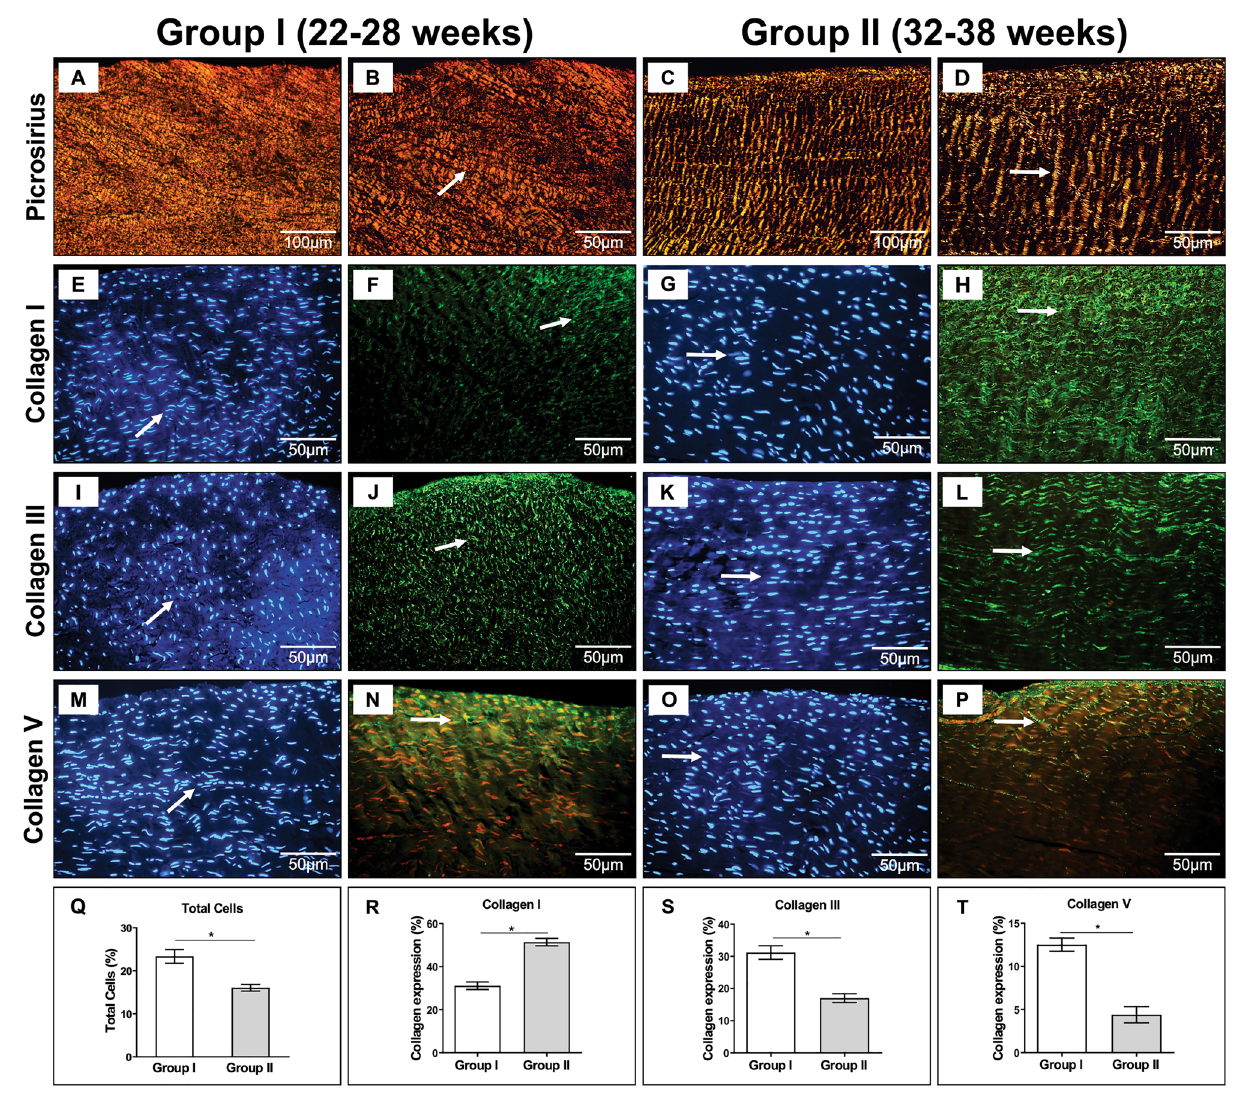
Figure 3. Collagen molecular architecture and cells distribution. ( A , B ) note reddish-orange birefringent collagen fibers analyzed by picrosirius under polarization in Group I (n = 5) human fetal tendons with a fragmented and disarranged pattern. In contrast, the collagen fibers stay in parallel or linear orientation in Group II (n = 4) tendons, ( C , D ) (arrows). ( E , I , M ) fluorescence microscopy by DAPI staining to identify the cell nucleus, with a large amount of cells with diffuse pattern in Group I tendons and in ( G , K , O ) demonstrate Group II tendon specimens with uniform and linear arrangement of the nuclei (arrows). ( F , J , N ) Immunostaining to collagen I, III and V visualized under fluorescence microscopy of Group I, demonstrating the reticulated pattern of collagen types. In contrast, ( H , L , P ) uniform green fluorescence and parallel orientation of collagen type I, III and V fibers in all areas of Group II tendons. ( Q ) A graphic representation of the total number of cells in Group I compared to Group II tendons (23.35 ± 1.74 vs. 16.07 ± 0.77; p < 0.04). A graphic representation of the amount (percentage of total tendon area, mean and standard deviation) of collagen I (51.40 ± 1.71 vs. 31.11 ± 1.74; p < 0.016) ( R ), collagen III (31.19 ± 2.10 vs. 17.02 ± 1.37; p < 0.015) ( S ) and collagen V (12.52 ± 0.76 vs. 4.392 ± 0.76; p < 0.016) ( T ) in the Group I in compared to Group II tendons. GraphPad Prism 6.0 software: Mann Whitney U test; P-values < 0.05 were considered observed mainly close to the blood vessels, as demonstrated by Lui et al. in their evaluation of adult tendons, suggesting that they may respond to local and systemic regulatory signals 34 . Russo et al. also demonstrated a high expression of markers that characterize mesenchymal cells in fetal tendons of younger sheep when compared to more mature and adult fetal tendons 19 . Adult mesenchymal stem cells are able to differentiate into: bone, cartilage, muscle, medullary stroma, tendon, ligament, fat, and other connective tissues in a sequence of lineage transitions. Caplan et al. demonstrate that bioactive molecules secreted by these cells were able to promote neovasculariza- tion, migration, immunoregulation, cell proliferation, synthesis, and remodeling of the extracellular matrix in the tissue 35 . However, he states that it is still unclear whether tendon stem cells work to replace damaged tendons or to establish a microenvironment for injury repair. Still, both can occur in vivo after tendon injury.